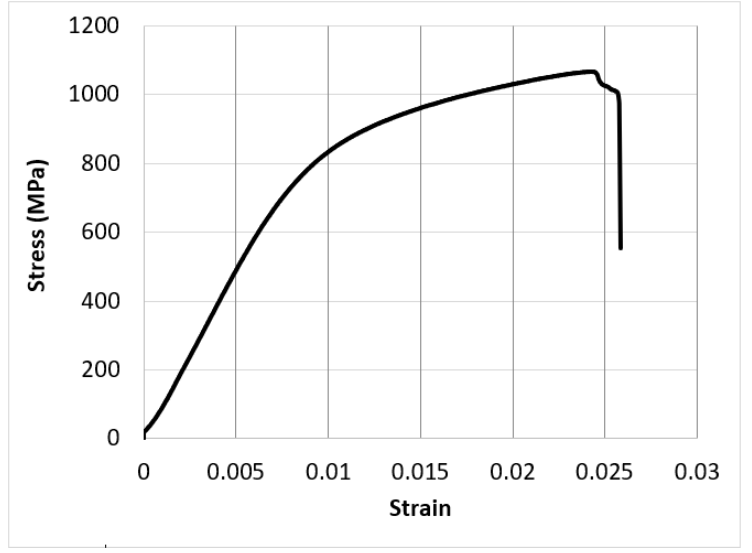
Figure 7. A fracture compression test results of a Ti-6Al-4V sample fabricated using LPBF.